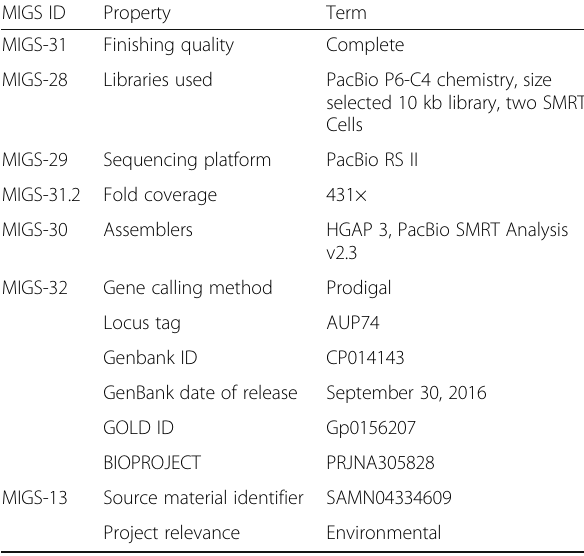
Table 2 Project